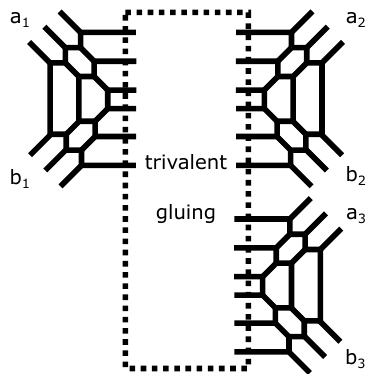
Figure 15. The labeling of [( a 1 , a 2 , a 3 ) , ( b 1 , b 2 , b 3 )] for each SU(3) in the web diagram in figure 11.